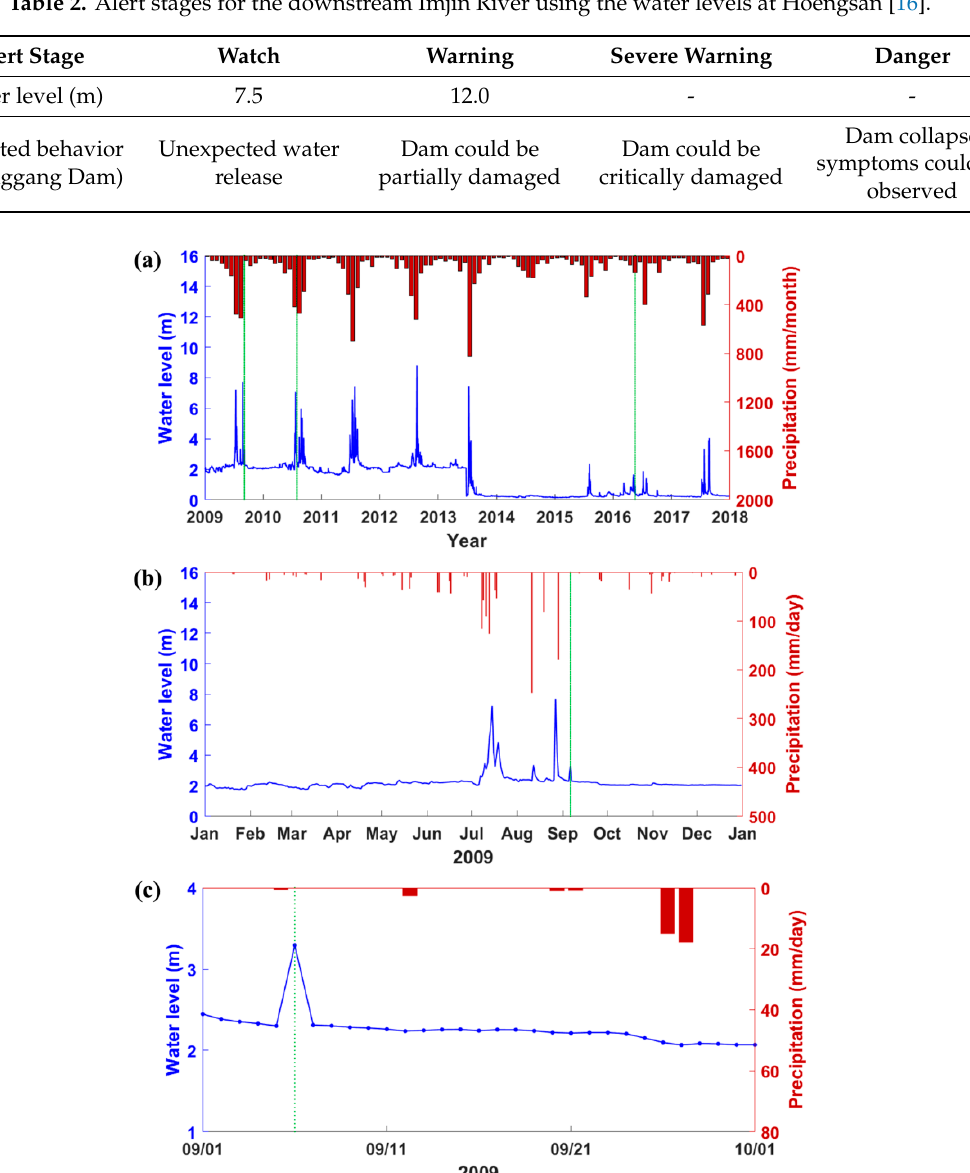
Figure 7. ( a ) Daily mean water levels at the Hoengsan station from 2009 to 2017 obtained from WAMIS (http://www.wamis.go.kr) and monthly precipitation measurements over the Hwanggang Reservoir for the same period from the Climate Hazard group Infrared Precipitation with Stations (CHIRPS) dataset. ( b , c ) are enlarged for visual clarity with daily CHIRPS dataset for the year 2009 and for September 2009, respectively. The green lines in Figure 7a indicate three water conflicts [23], which occurred on 6 September 2009, 2 August 2010, and 17 May 2016. Note that bias in annual minimum water levels before and after 2013 was due to the location change of the Hoengsan station, which was moved slightly upstream after the construction of the Gunnam Dam in 2013 [34].